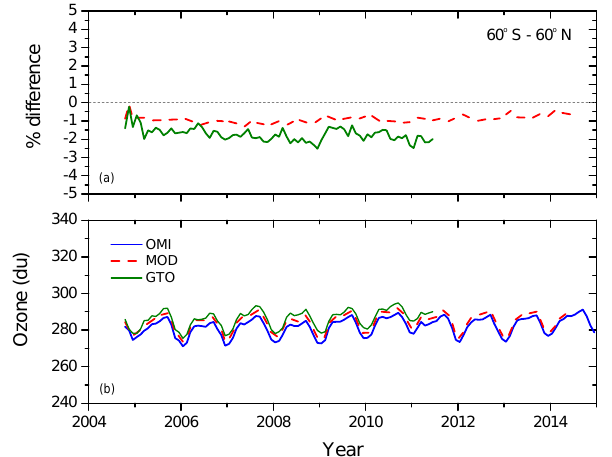
Figure 12. Total column ozone from OMI, the MOD (merged ozone data) based on SBUV/2 instruments, and the GTO (GOME-type To- tal Ozone) merged ozone based on GOME instruments and SCIA- MACHY (b) and differences in percent of OMI minus each ( a ; from McPeters et al.,